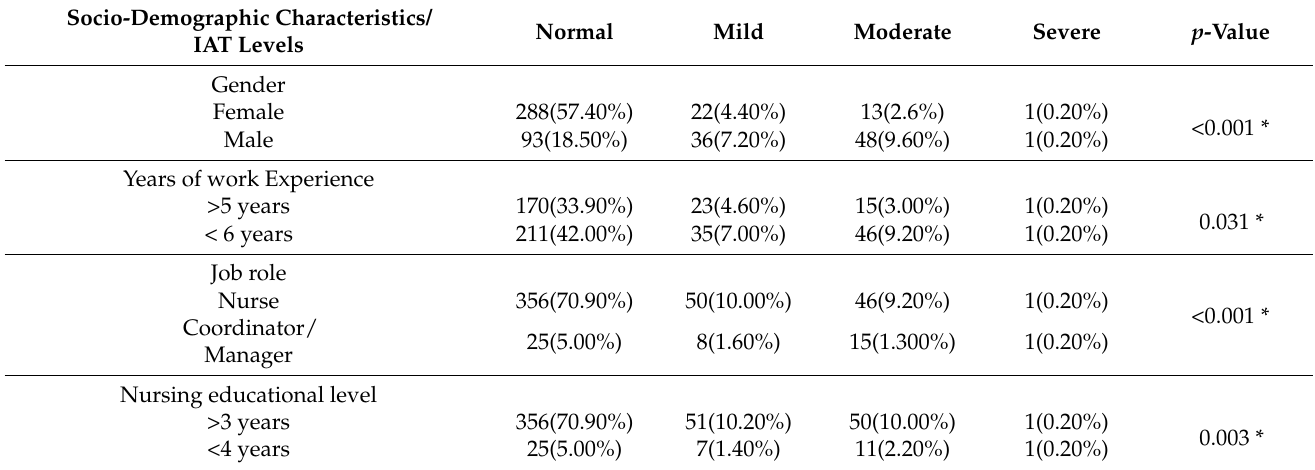
Table 1. Sampling characteristics according to IAT levels ( n = 502).